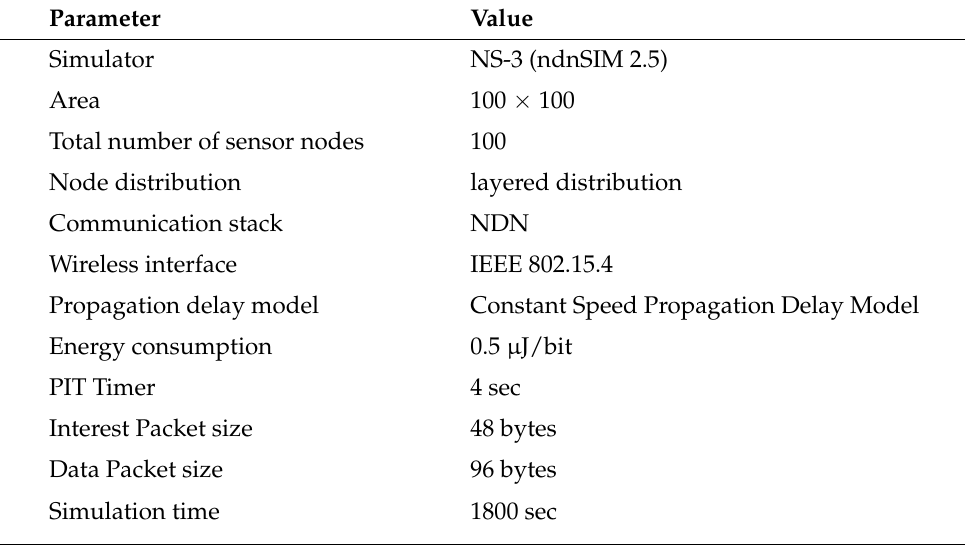
Table 2. Simulation